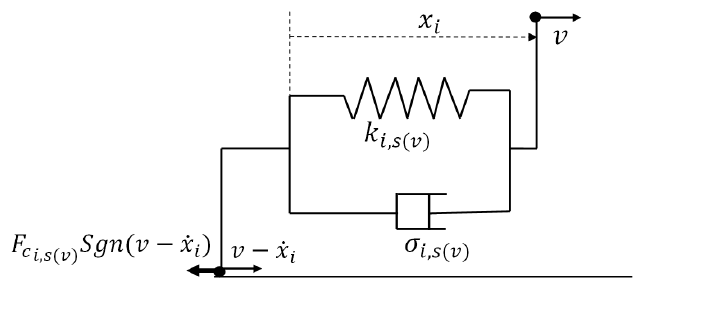
Figure 5. Single visco-elastic